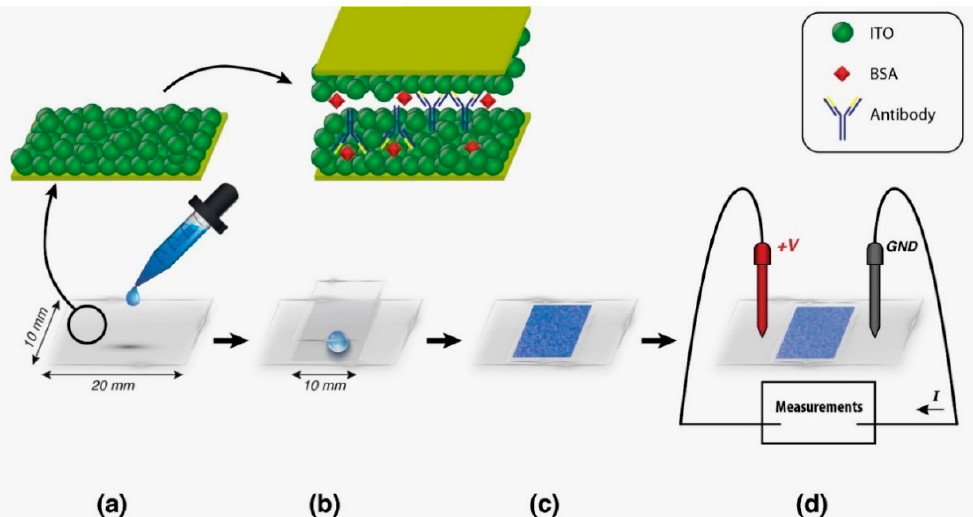
Figure 1. Sensor preparation. ( a ) Preparing a fabricated ITO-coated glass slide (20 mm long and 10 mm wide) with a coating thickness of 122 ± 5 nm as the sensor. ( b ) Pipetting 5 μ L of the sample over the slide. ( c ) Sandwiching the sample with the help of another slide. ( d ) Measuring the change in resistance of the sensor based on binding between the sample and the transducer.